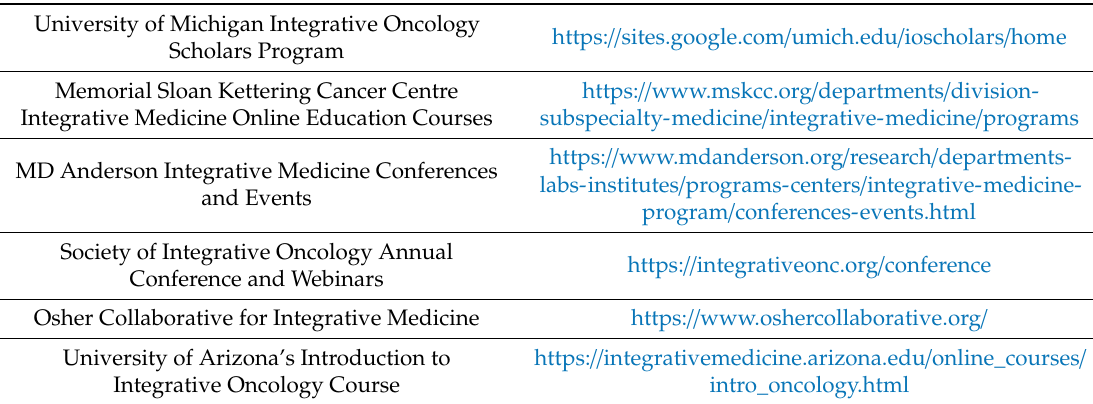
Table 2. Integrative Oncology Education Programs and